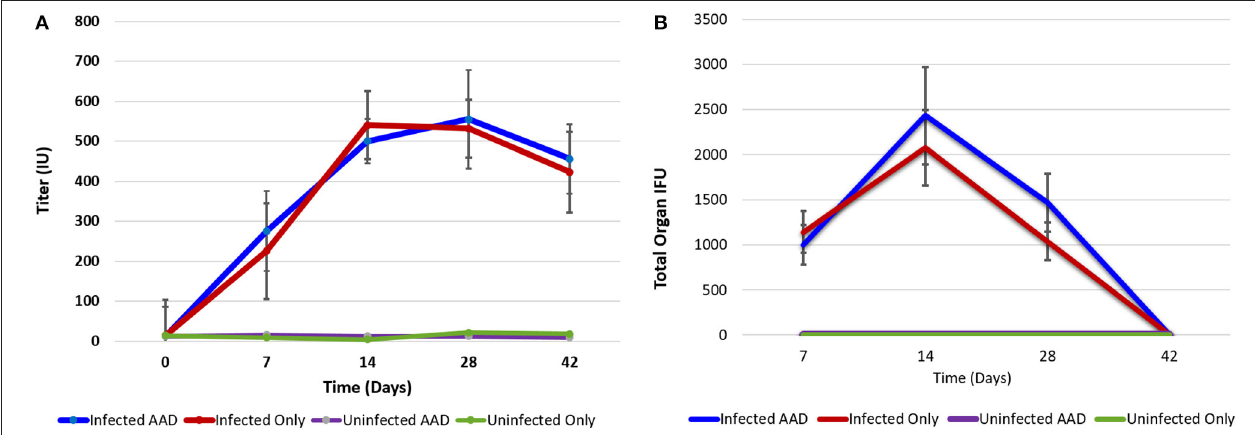
FIGURE 2 | Chlamydia antibody titer and lung bacterial load over time. Antibody titer graph shows strong antibody responses to Chlamydia from infected animals but no antibody production in uninfected groups. Infected animals titers to Chlamydia began decreasing once infections cleared (A) . Chlamydial carriage in the lung peaked 14 days pi (B) . Chlamydial organisms were not isolated from lung tissues at 42 days post-infection.